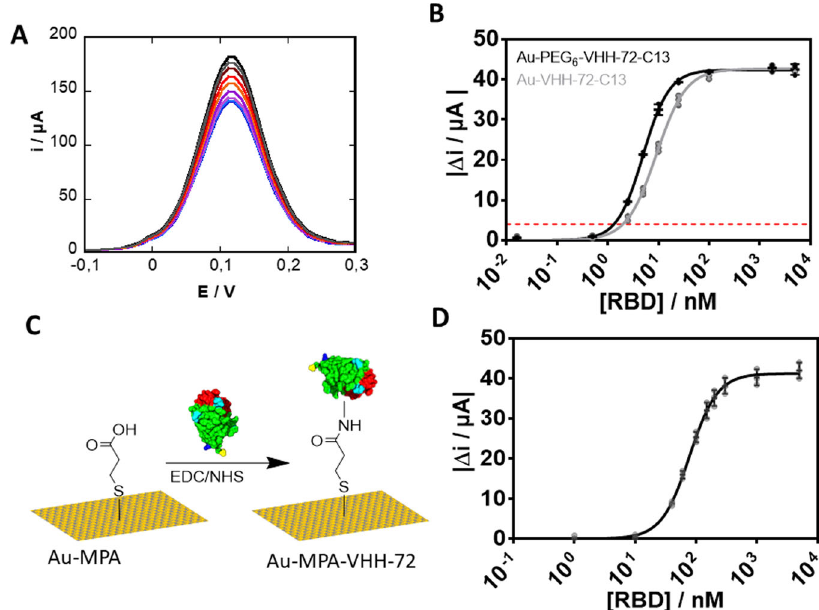
Fig. 4 Performance of Au-VHH-72-C13, Au-PEG 6 -VHH-72-C13, and Au-MPA-VHH-72 electrodes. A Differential pulse voltammograms (DPVs) of Au- PEG 6 -VHH-72-C13 in ferrocenemethanol (1mM in 0.1 M PBS, pH 7.4) initially (black) and after addition of RBD (1.2, 2.5, 5, 10, 25, 100, 1770, 5000nM). B Dose – response curve of RBD of Au-PEG 6 -VHH-C13 as well as Au-VHH-C13 electrodes. Data were fi tted to a Langmuir adsorption isotherm assuming a 1:1 complex between the antigen (RBD) from the solution and the linked VHH-72 receptor. C Surface attachment strategy of VHH onto 3-mercaptopropionic acid-modi fi ed gold (Au-MPA) interfaces using EDC/NHS coupling chemistry (protein, linkers, and gold surface are not drawn to scale with respect to each other). D Dose – dependent response curve of Au-MPA-VHH electrode to increasing RBD concentrations. The results are expressed as the mean ± SEM of at least 3 independent samples for each group.